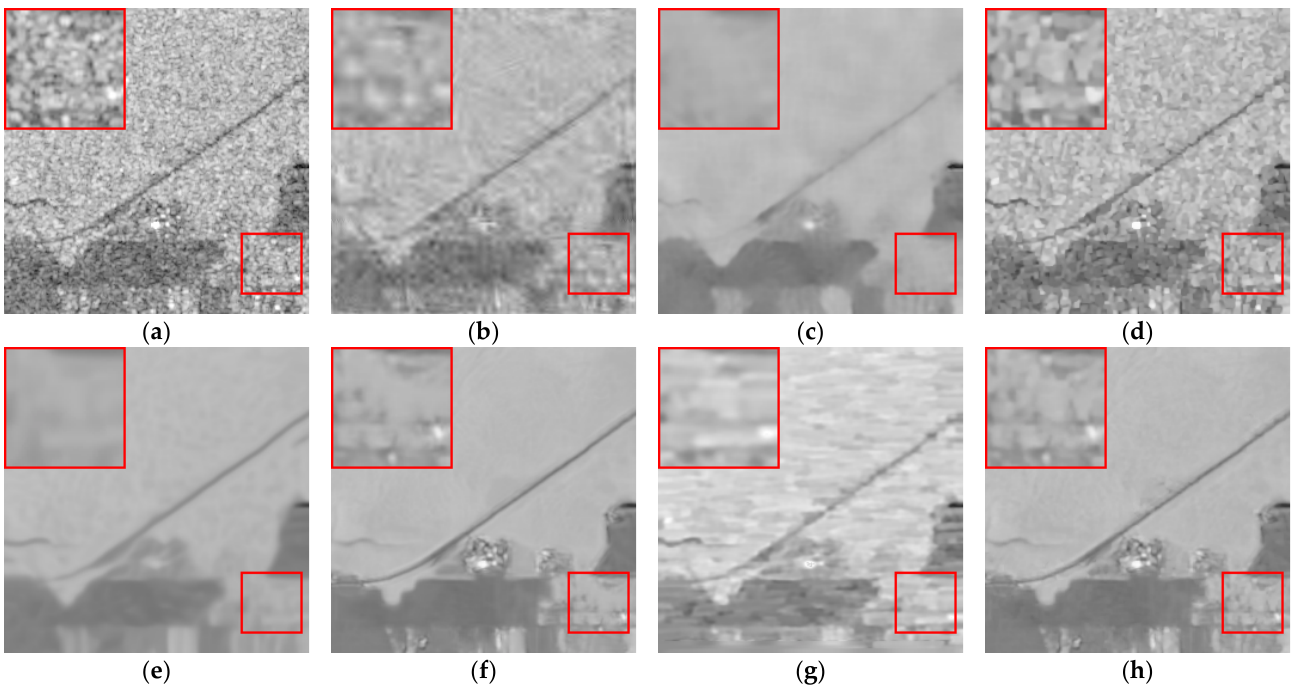
Figure 17. The results of all filters on RS3. The red box highlights the zoomed region of interest. ( a ) Noisy image; ( b ) W-C; ( c ) PPB; ( d ) SAR-BM3D; ( e ) H-WNNM; ( f ) GNLM; ( g ) FANS; ( h ) Proposed method.